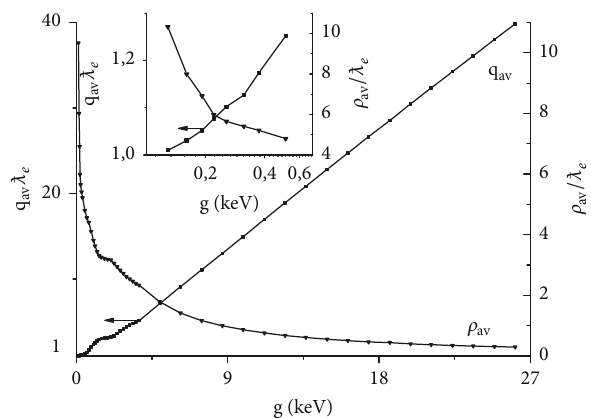
Figure 1: The average transverse momentum 𝑞 𝑎 V (47) and the average transverse radius 𝜌 𝑎 V (49) as functions of the massless boson kinetic energy. Inset: the same in the low-energy